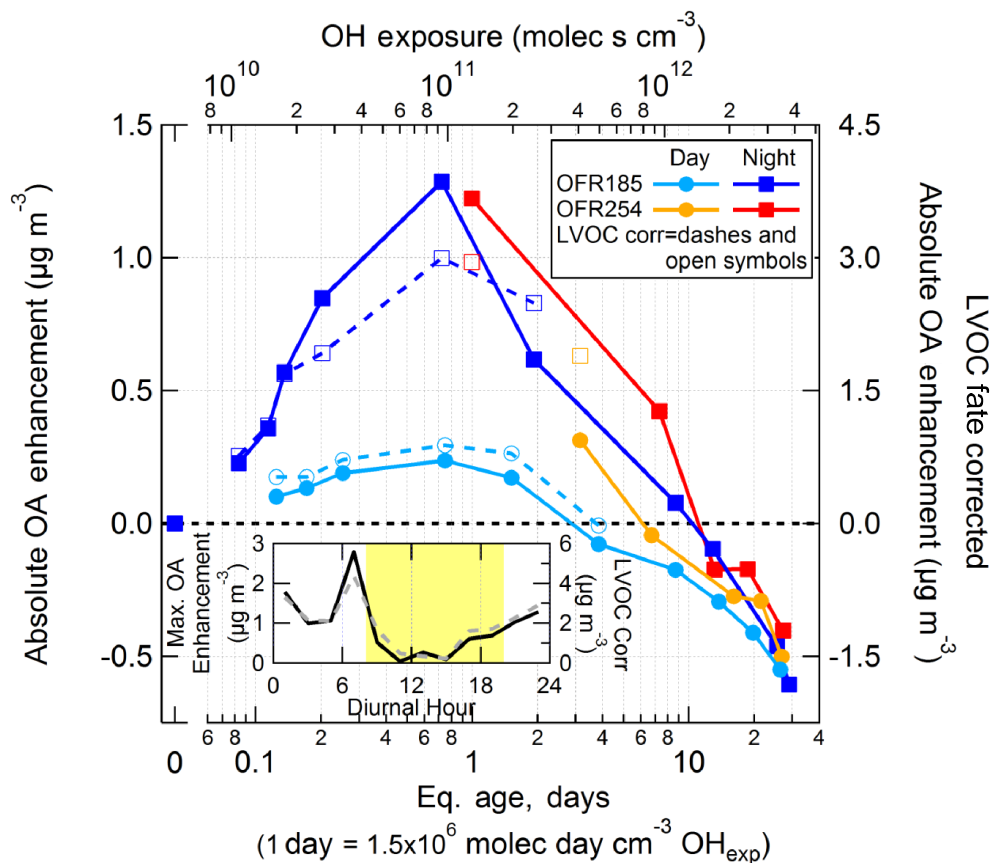
Figure 7. Comparison of absolute OA enhancement from OH oxidation using the OFR185 and OFR254-70 methods, binned by photochem- ical age and separated into daytime (08:00–20:00LT) and nighttime (20:00–08:00LT) to reflect the changes in ambient SOA precursors between day and night. Data are shown with (right axis, open symbols, and dashed lines) and without (left axis, closed symbols, and solid lines) the LVOC fate correction described in Sect. 3.3. Inset: the maximum OA enhancement (all data 0.4–1.5 days eq. age) as a function of time of day, with (dashed) and without (solid) the LVOC fate correction. OFR254-70 measurements with positive OA enhancement were multiplied by the ratio of ambient MT concentrations measured during OFR185 vs. OFR254-70 sampling periods (ratio = 1.8). Negative OA enhancements were not normalized in this way since the amount of mass lost due to heterogeneous oxidation would not necessarily correlate with ambient MT